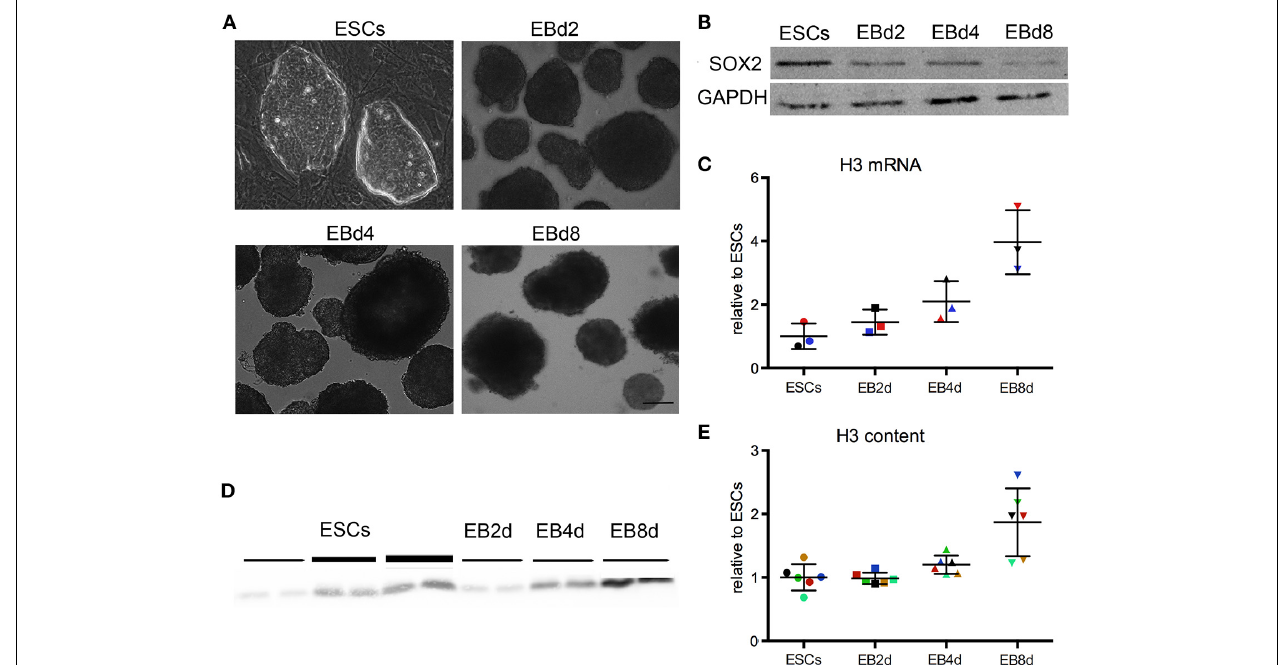
FIGURE 3 | (A) CCE and R1 ESCs were cultured under ES like conditions and differentiated spontaneously to Embryoid Bodies (EB) for 2, 4, and 8 days. We found no statistical difference between R1 and CCE cells, or between EBs derived from the different ESC lines. Scale bar 50 μ m. (B) Western blot for SOX2 protein, which gradually decreases in EBs. (C) ESCs express less H3 mRNA. Each dot represents a different biological replicate. Color codes identify samples analyzed in the same batch the same day; different colors represent samples analyzed in different days. The mean and standard deviation are indicated by horizontal lines. The